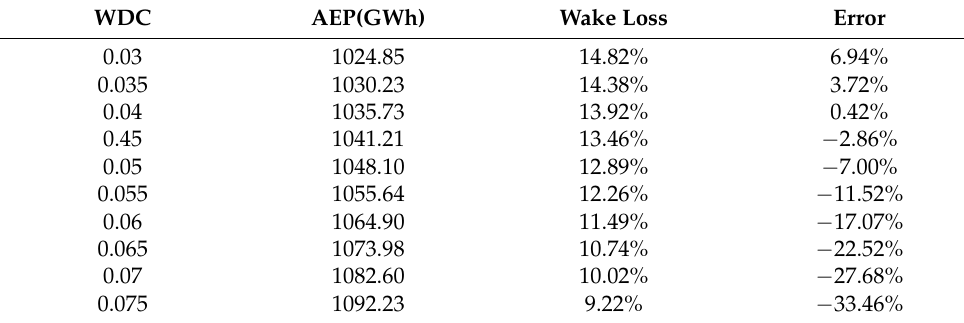
Table 4. AEP and wake loss by different WDC of Yangkou Wing Farm.